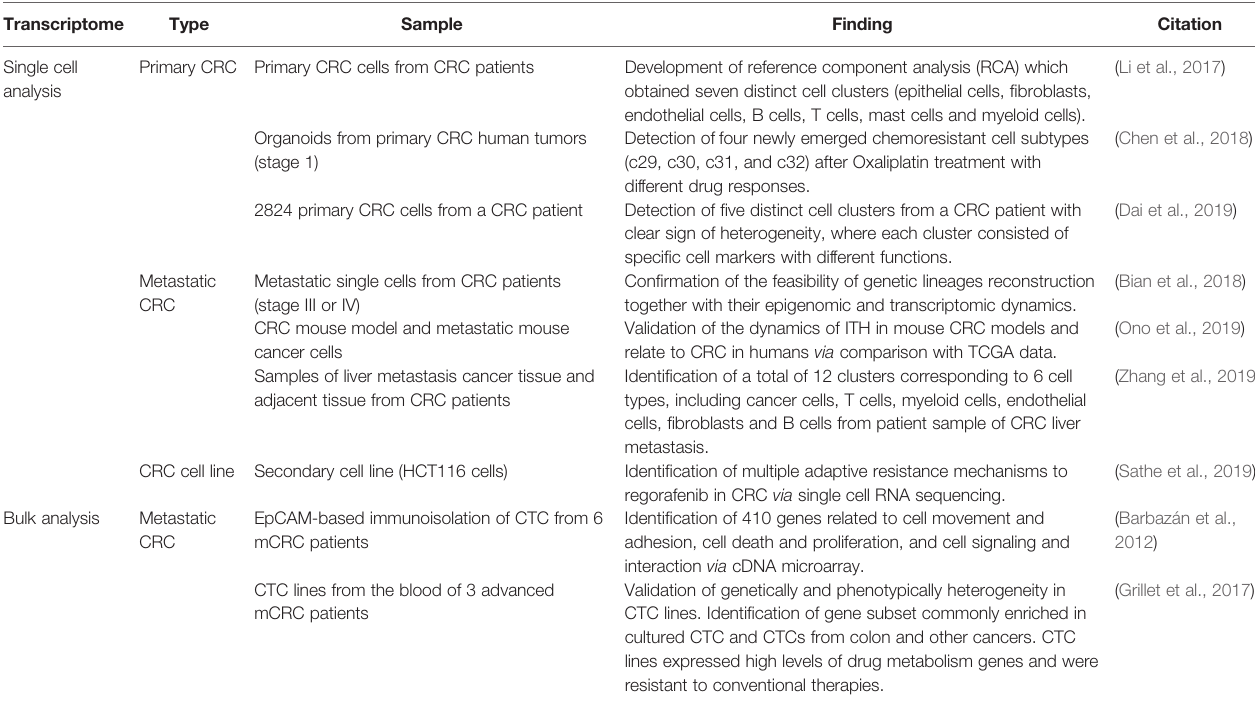
TABLE 1 | Summary of recent fi ndings of single-cell RNA-seq and bulk analysis of CTCs in